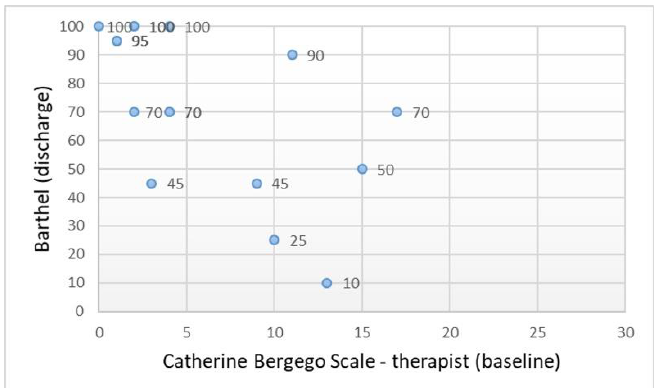
Figure 5. Scatter plot showing the relationship between the behavioral scale and functional indepen- dence in ADL ( n = 17).